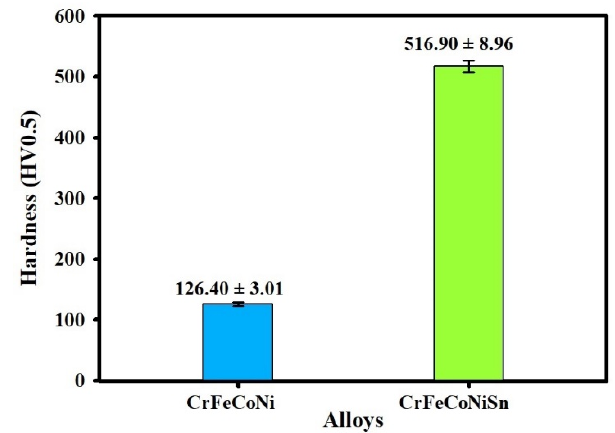
Figure 3. Hardness of CrFeCoNi and CrFeCoNiSn alloys at HV0.5.